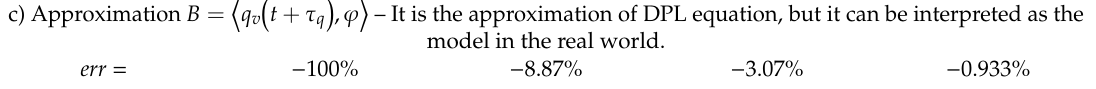
Table A1. Value of relative error calculated for di ff erent time values a, b, and the test function Equation (A9). a = τ q , b = τ q a = τ q , b = τ T a = τ q , b = 3 τ T a = τ q , b = 10 τ T (cid:28) (cid:29) ∂ q ϕ ⇒ A = B v ( t ) q v ( t ) + τ q a) Derived from DPL model B = ∂ t , err = 0% 0% 0% 0% (cid:10) (cid:11) q v ( t ) , ϕ b) Approximation B = err = − 62.37% − 5.52% − 1.91% − 0.58% (cid:68) (cid:16) (cid:17) (cid:69) q v t + τ q c) Approximation B = , ϕ – It is the approximation of DPL equation, but it can be interpreted as the model in the real world. err = − 100% − 8.87% −